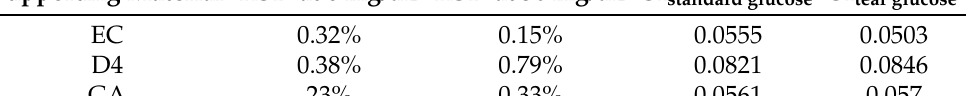
Table 2. Reversibility performance and comparison of SI for standard and tear glucose with the three supporting materials EC, D4 and GA in glucose according to the results of [58].